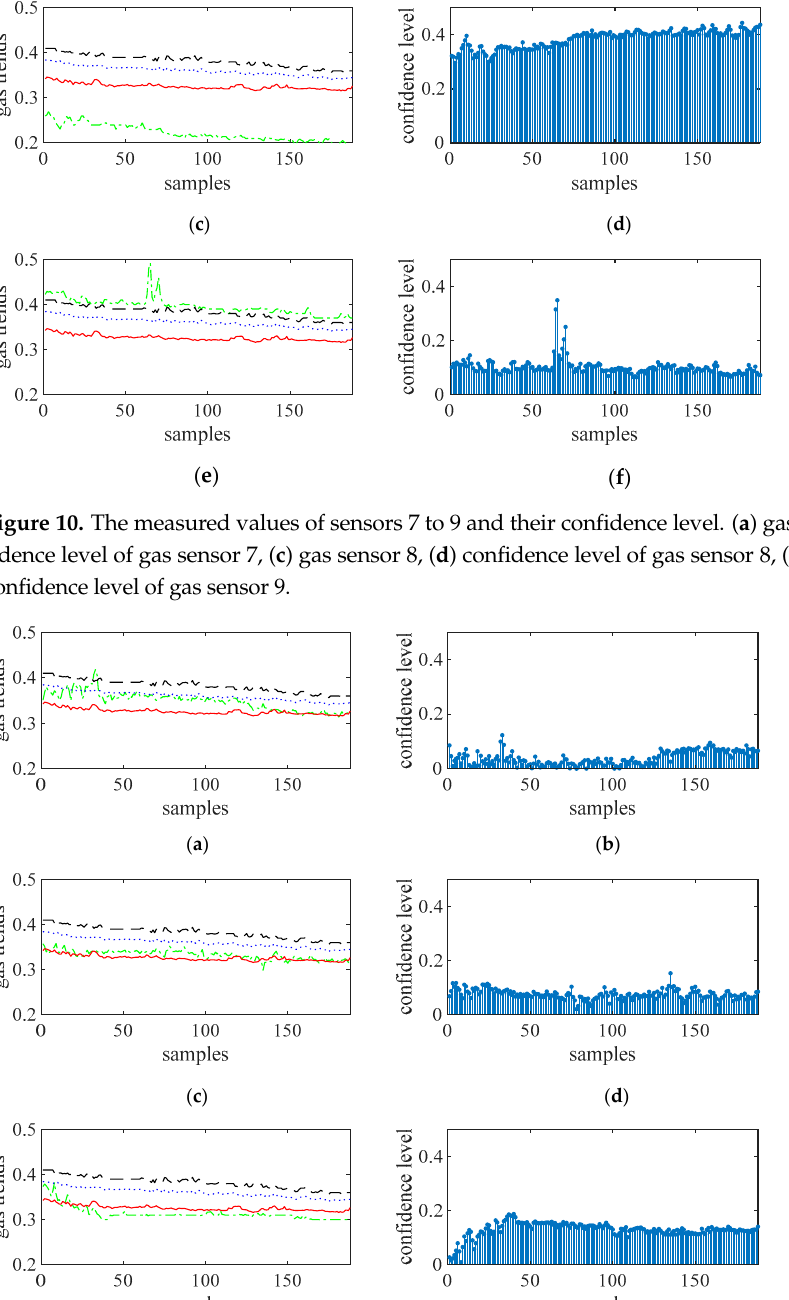
Figure 11. The measured values of sensors 10 to 12 and their confidence level. ( a ) gas sensor 10, ( b ) confidence level of gas sensor 10, ( c ) gas sensor 11, ( d ) confidence level of gas sensor 11, ( e ) gas sensor 12, ( f ) confidence level of gas sensor 12. ( f ) confidence level of gas sensor